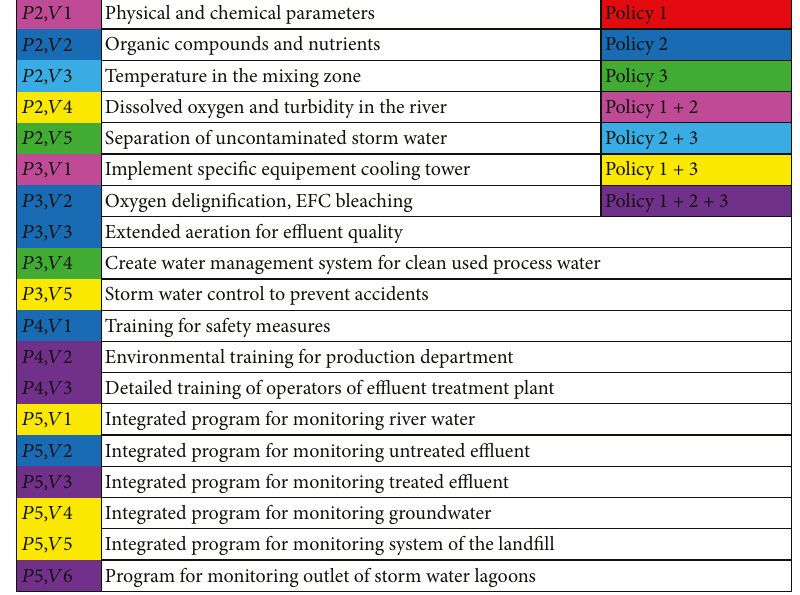
Figure 5: Colour-coded selection of the parameter values that generate optimal combinations for policies 1, 2, and 3, for a new WWTP.